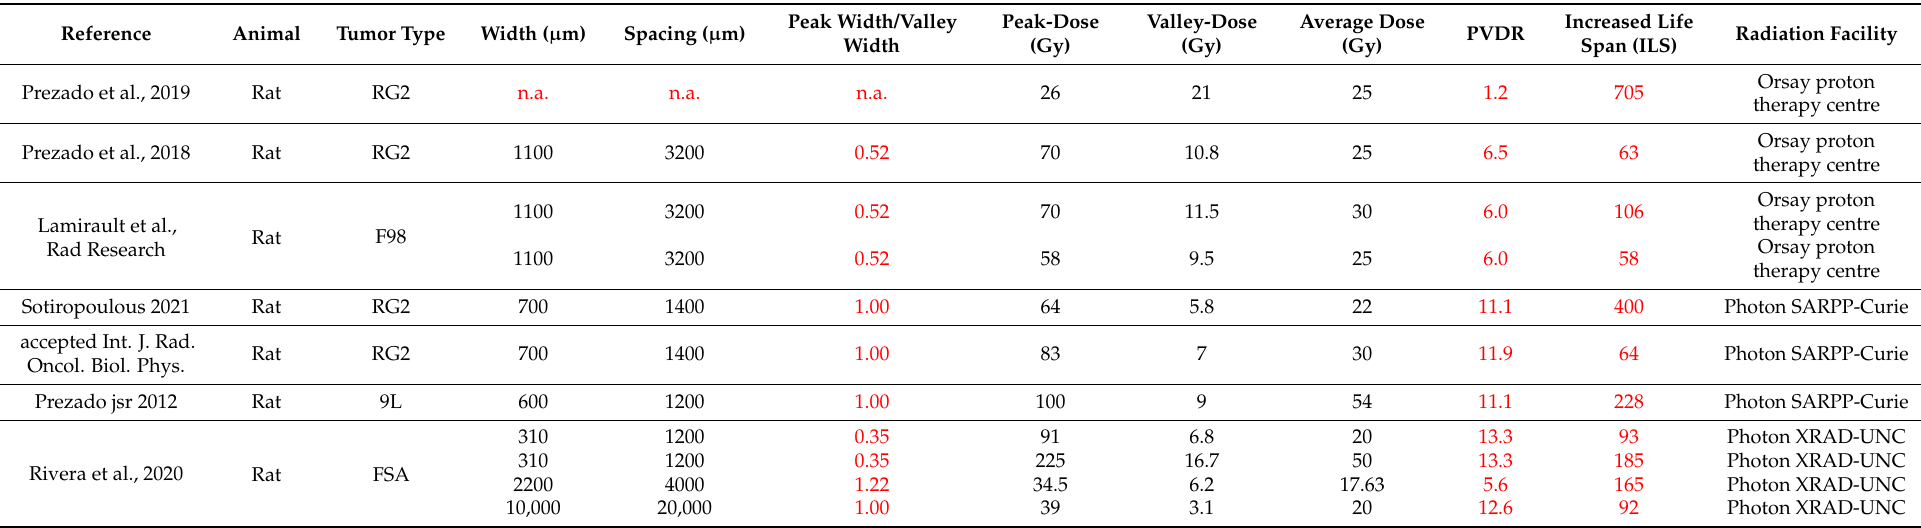
Red color represents Value calculated by the